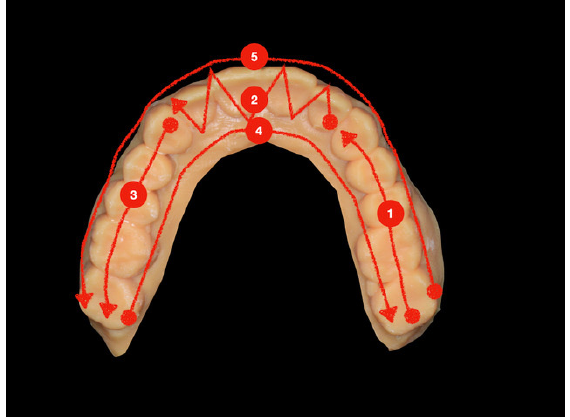
Figure 1. The path of the scan in the suggested